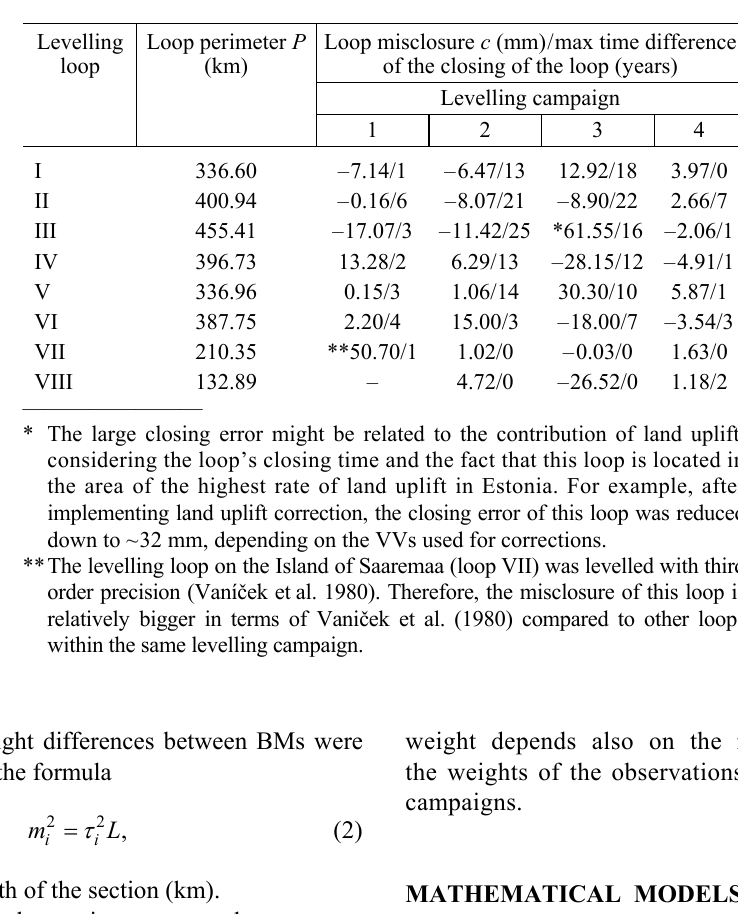
Table 1. Misclosures of the levelling loops of the common levelling network. A loop was not established on the Island of Hiiumaa (loop VIII, Fig. 1) during the first levelling